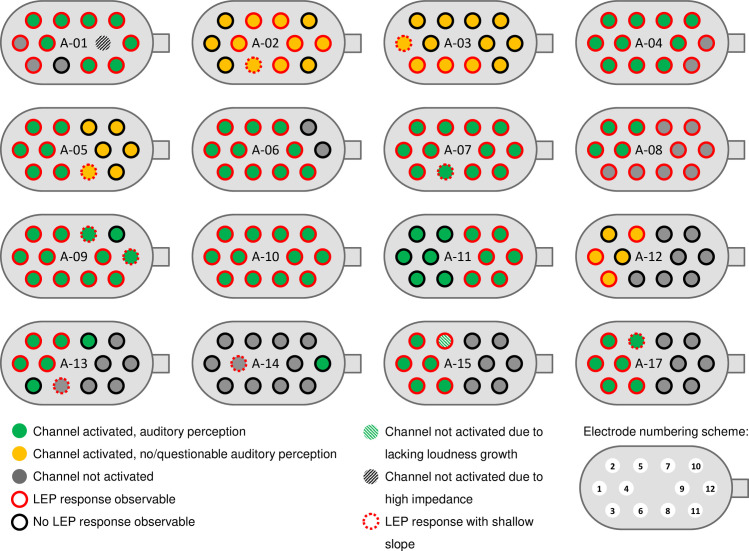
Electrode status for each patient.LEP measurements have been performed in 16 patients. The color indicates if an electrode contact was activated or deactivated and if LEP responses were found or not.